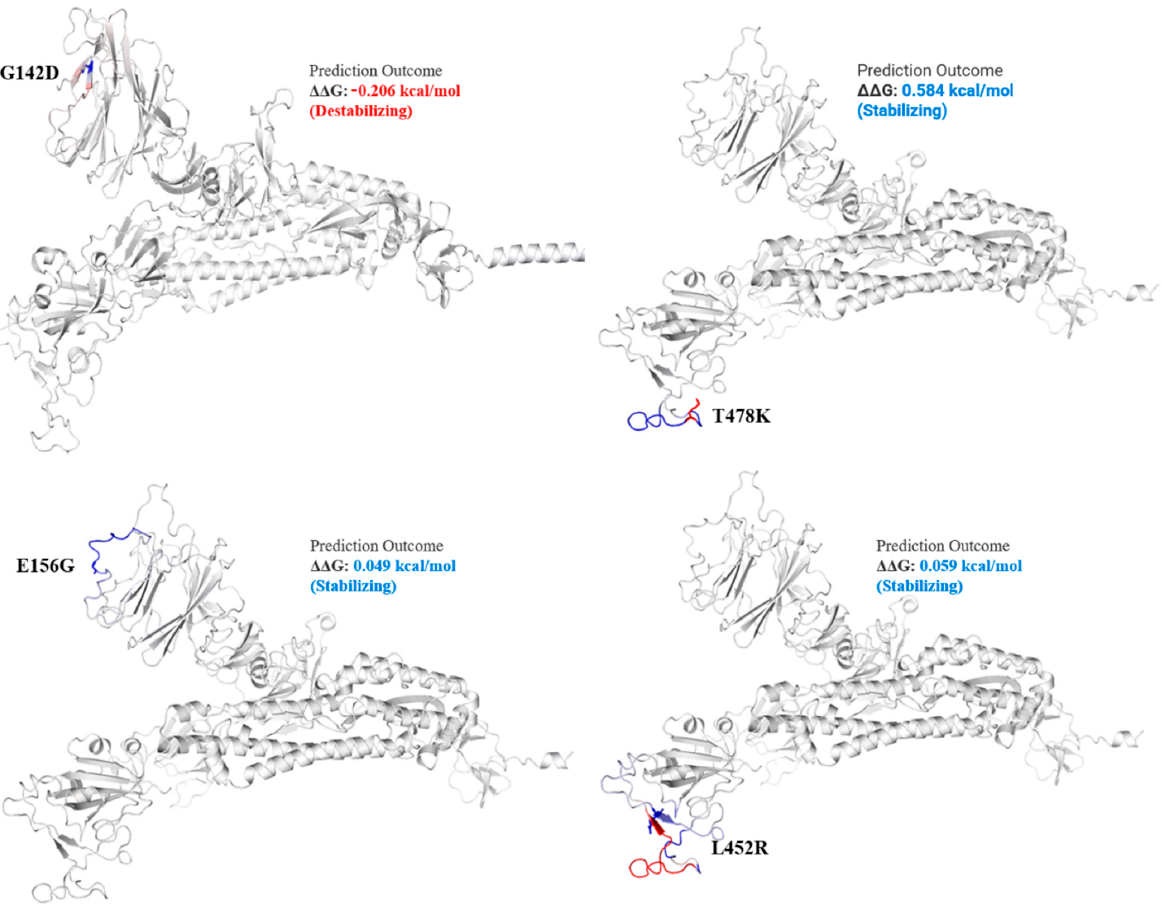
Figure 3. Mutation effect on S protein structure stability and flexibility. Mutants G142D, T478K, E156G, and L452R in S protein, exhibited stabilizing effect. The blue region shows rigidification of structure behind mutations and red shows gain in flexibility.